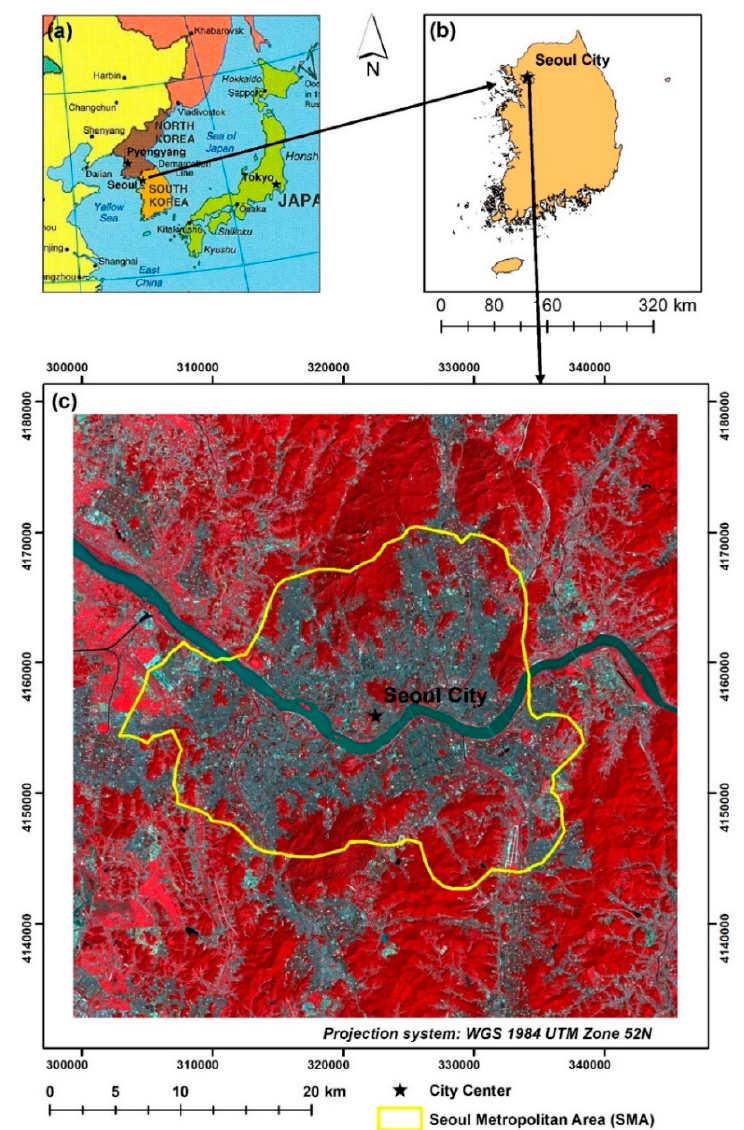
Figure 1. Location map of the study area. ( a ) Map of Southeast Asia with the Republic of Korea [44]; ( b ) location of the Seoul metropolitan area (SMA) [45]; and ( c ) study area within the SMA (Landsat-8 OLI/TIRS in false-color composite (Bands 5, 4, 3; 26 August 2017) with the city center [46].